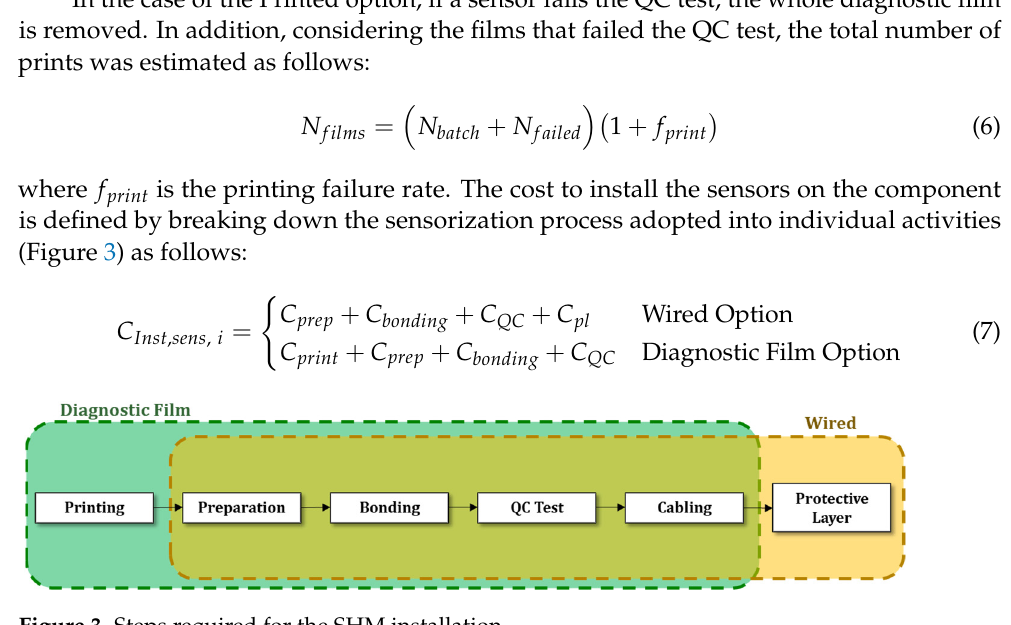
Figure 3. Steps required for the SHM